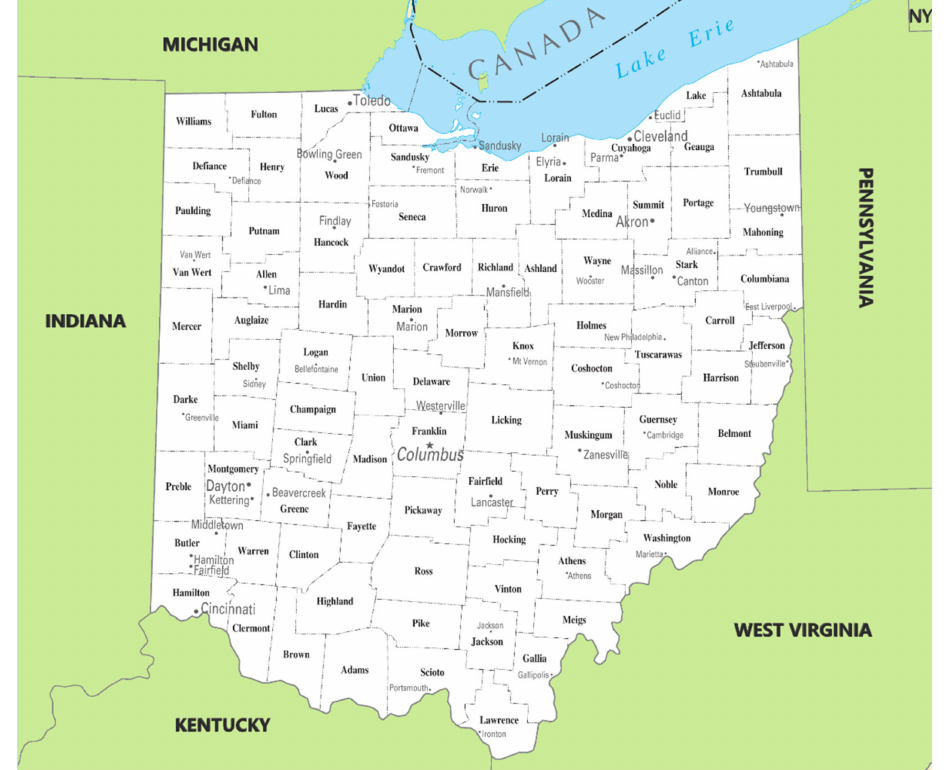
Figure 1. Map of Ohio depicting its 88 counties, major cities, and some towns (star indicates state capital, Columbus). Map modified from http://mapsof.net/ohio/ohio-cities-and-towns (accessed on 3 February